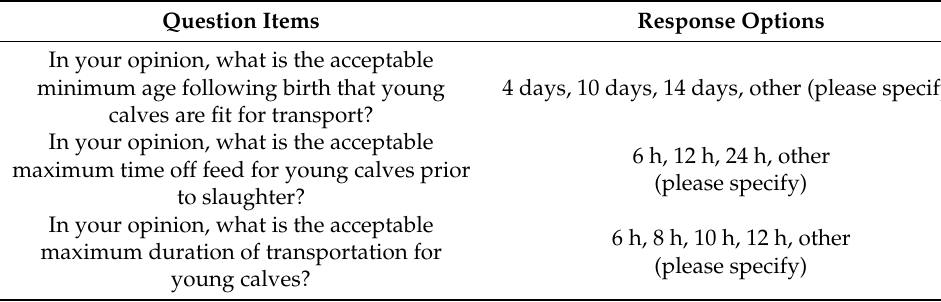
Table 1. Survey items used to determine whether veterinary opinions align with certain welfare provisions pertaining to young calves (up to 14 days of age) in New Zealand.